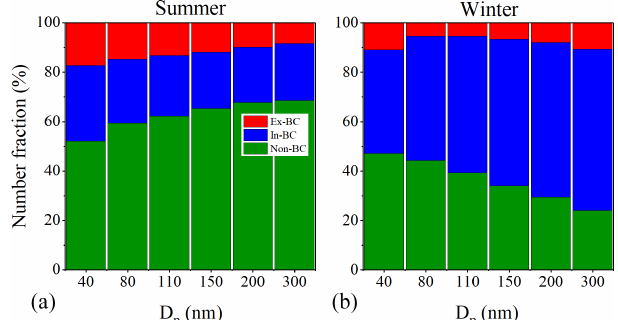
Figure 10. Size-resolved, campaign-averaged number fractions of Non-BC, In-BC, and Ex-BC during the winter (a) and summer (b)